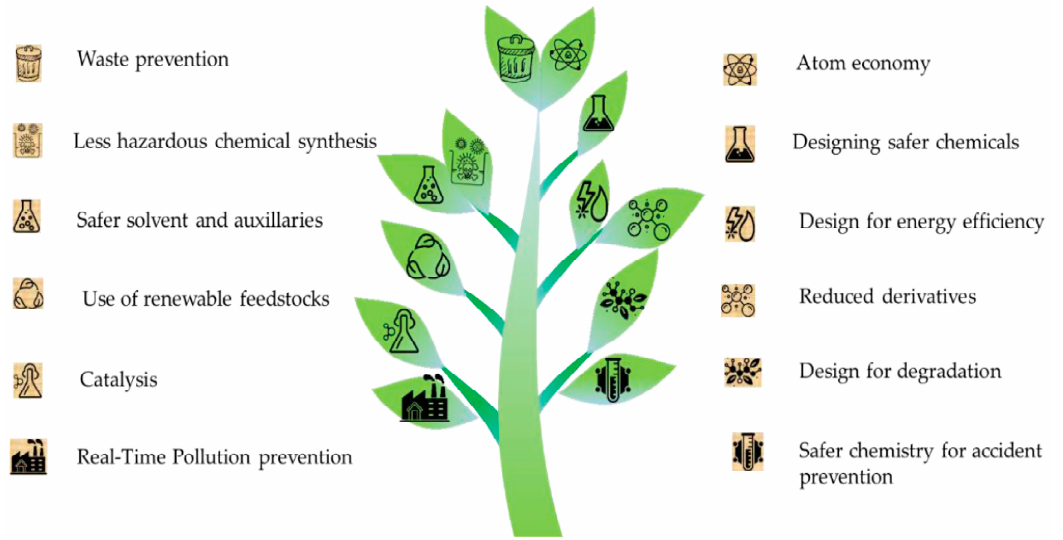
Figure 5. The 12 principles of green chemistry, adapted under a Creative Commons Attribution 4.0 License from [34] (p. 2) © 2019 Swaraj Rashmi Pradhan, Ram ó n Fernando Colmenares-Quintero and License from [34] (p. 2) © 2019 Swaraj Rashmi Pradhan, Ramón Fernando Colmenares-Quintero and Juan Carlos Colmenares Quintero. Juan Carlos Colmenares